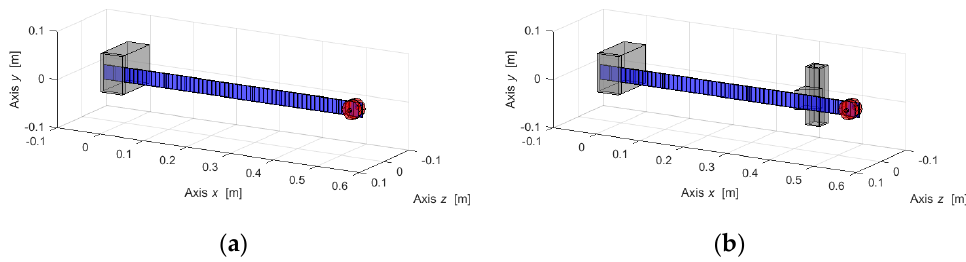
Figure 20. LUPOS model for clamped-free beam ( a ) and clamped-pinned-free beam ( b ). Table 6. Results of modal analysis in the xz eigenspace. Mode Clamped-Free (Hz) Clamped-Pinned-Free (Hz)